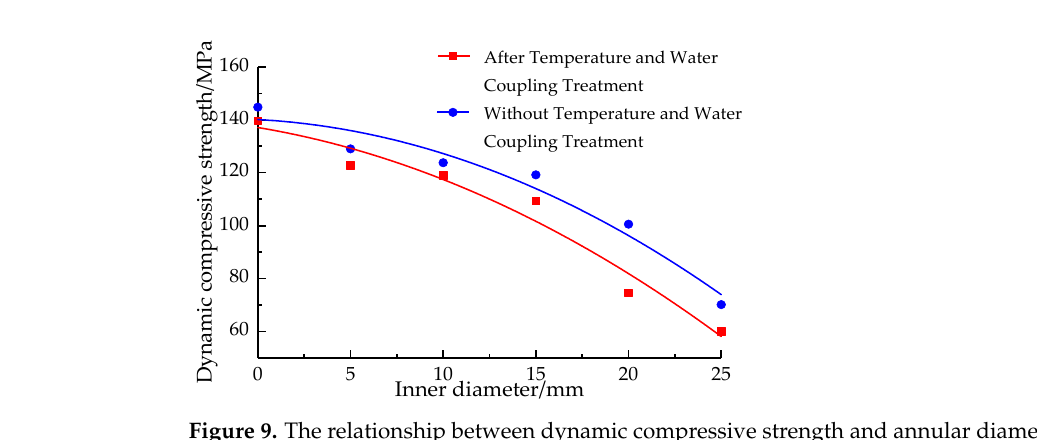
Figure 9. The relationship between dynamic compressive strength and annular diameter change.